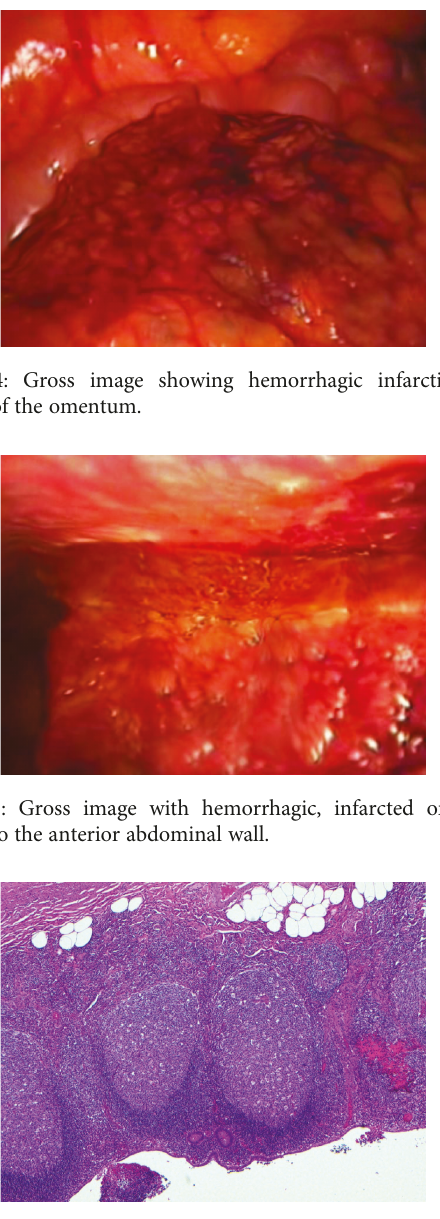
Figure 6: Peyer ’ s patches in the appendix with an area of hemorrhage.